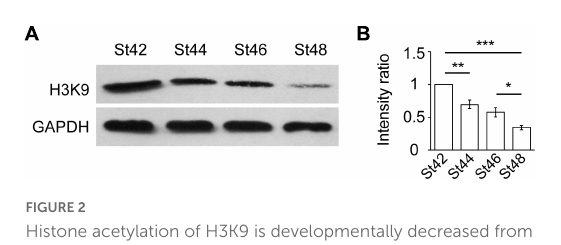
FIGURE2 Histone acetylation of H3K9 is developmentally decreased from stage 42 to 48 optic tectum. (A) Western blot analysis of H3K9 protein expression using an anti-H3K9ac antibody at St42, St44, St46, and St48. (B) The data shows that the relative intensity of H3K9 at St48 was significantly decreased compared to St42 and